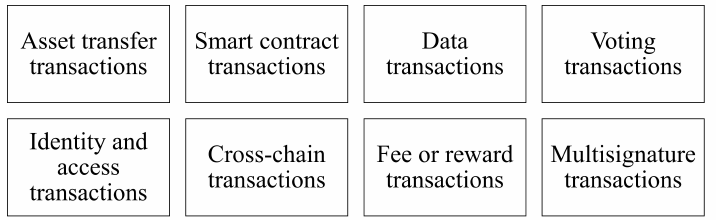
Figure 2. Transaction Types.